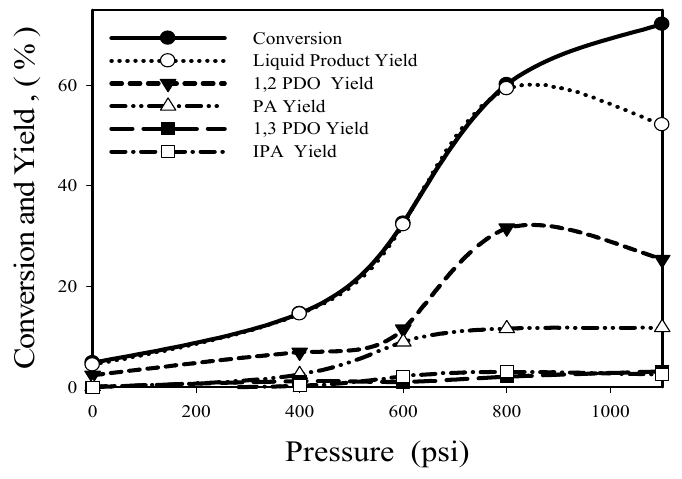
Figure 10. Influence of hydrogen pressure on glycerol conversion and product yield for the Re-08RuSi catalyst.